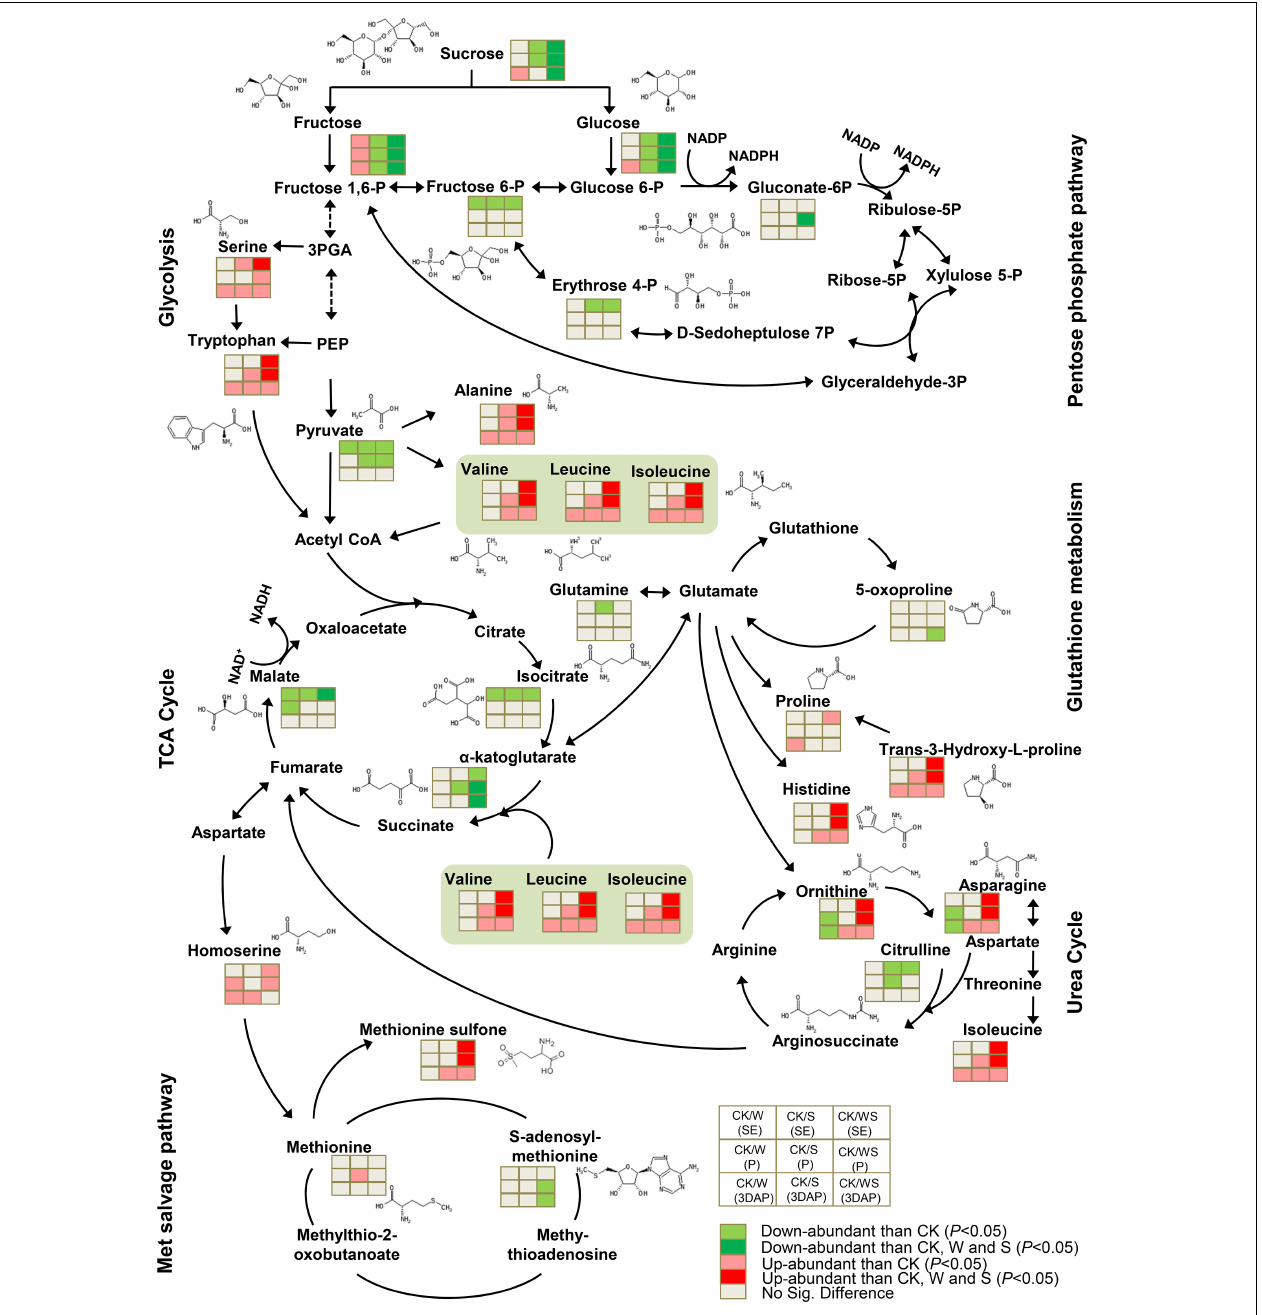
FIGURE 8 | Differences in metabolites involved in carbohydrate and amino acid metabolism in ovaries affected by waterlogging + shading (WS), waterlogging (W), and shading (S) treatment at SE (first silk emergence), P (full silk emergence) and 3DAP (3 days after pollination). Grids next to each metabolite represent accumulation of corresponding metabolites in the W, S, and WS groups at each time point. Colors correspond to the significance of the change in accumulation. Light red: more abundant than in control ( P < 0.05). Deep red: more abundant than in control, W, and S ( P < 0.05). Light green: less abundant than in control ( P < 0.05). Deep green: less abundant than in control, W, and S ( P < 0.05). Light gray: no significant difference compared with